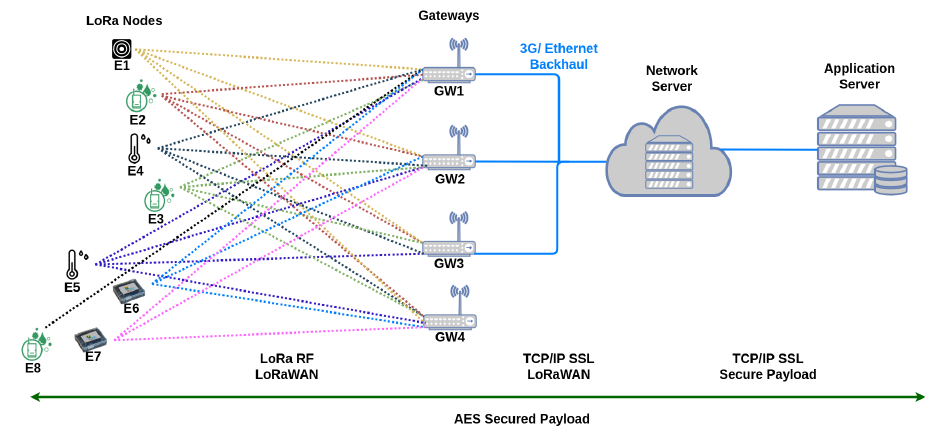
Figure 1. Illustration of the LoRaWAN topology based on Reference [32]. The Application Server is not used in our experiments.